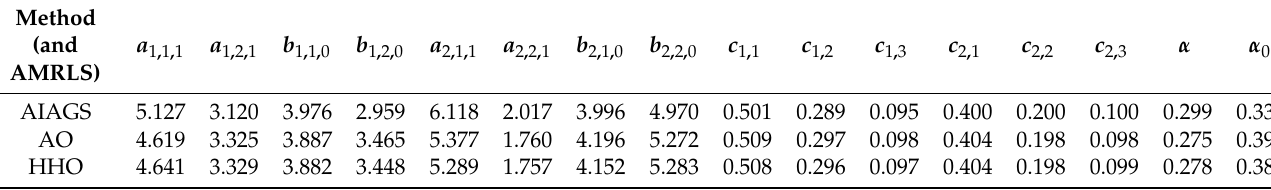
Table 4. The final identification results.